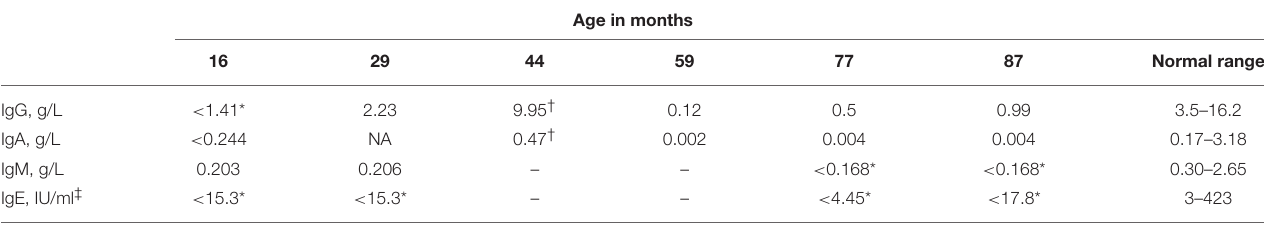
TABLE 4 | Quantification of serum Ig concentration of the SCID patient at different time